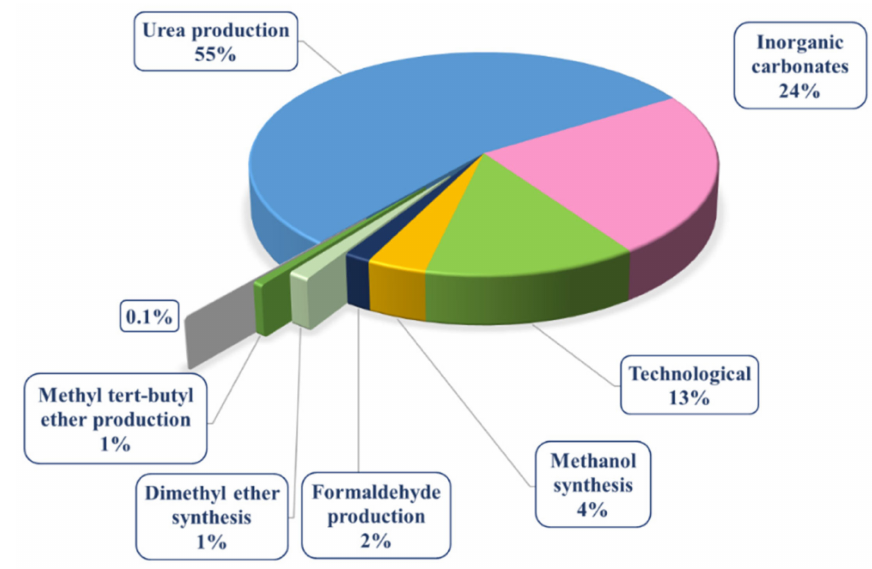
Figure 2. Industries that utilize CO 2 as a feedstock, adapted with permission from